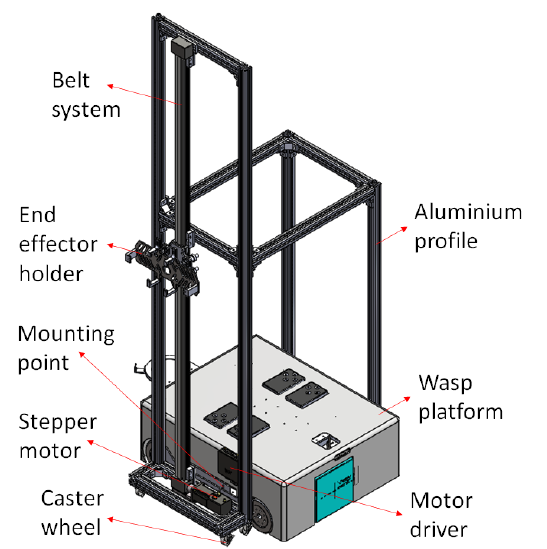
Figure 3. Integration of wall cleaning module with Wasp